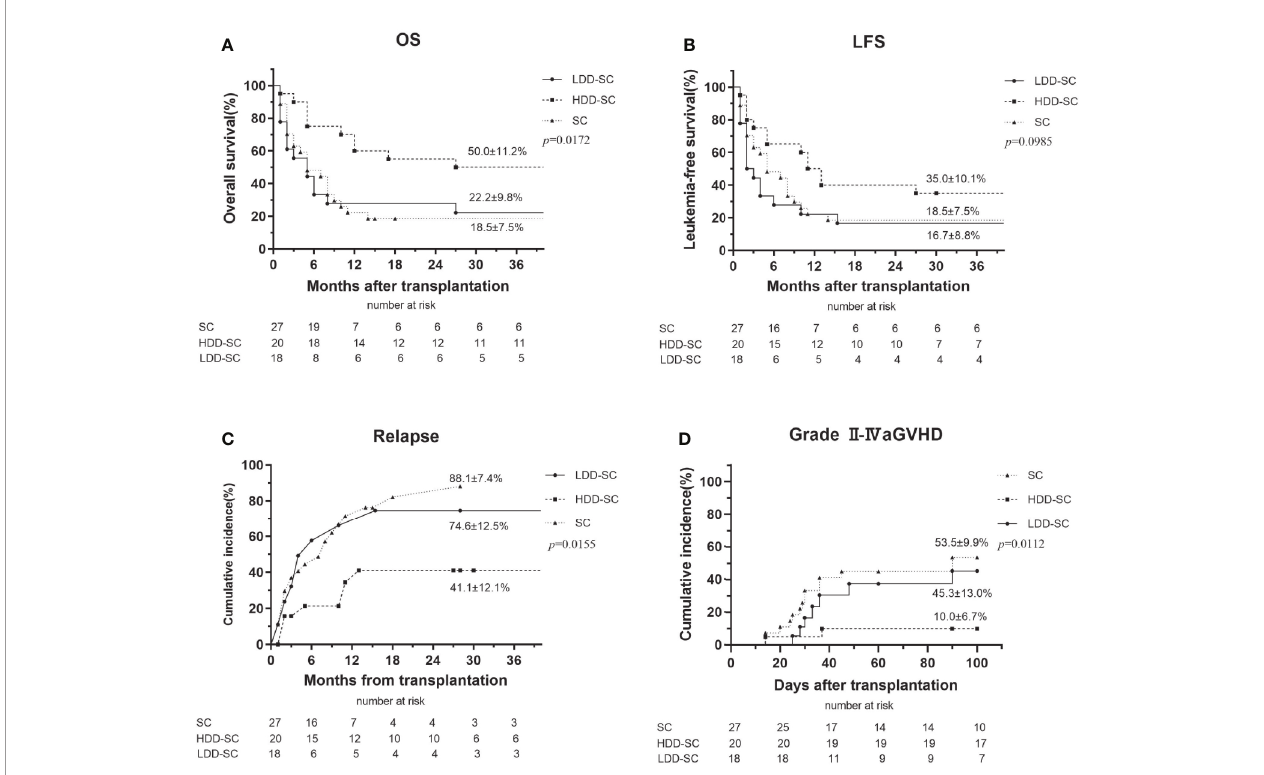
FIGURE 2 | Clinical outcomes for all patients. (A) Overall survival (OS), (B) leukemia-free survival (LFS), (C) relapse, and (D) grade II – IV acute graft versus host disease